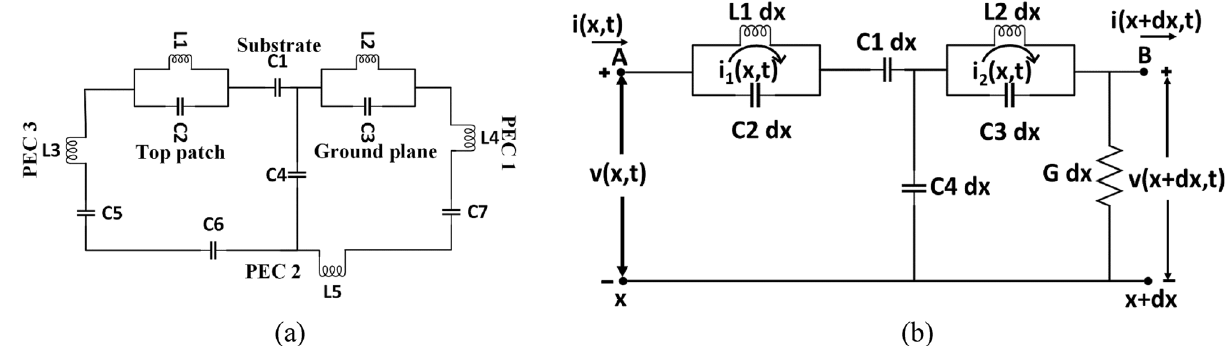
Figure 8. Analytical representation of 3D antenna ( a ) equivalent circuit of the 3D antenna ( b ) simplified equivalent circuit of 3D antenna for mathematical